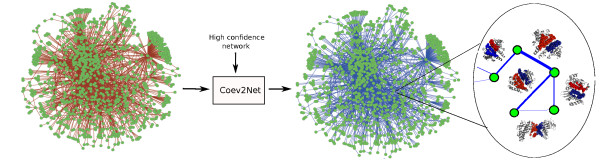
Framework for assessing confidence in a HTP PPI screen. Coev2Net, trained on a high-quality PPI network, is able to assign structure-based confidence scores for HTP PPI networks. Each node represents a protein and each edge the putative interaction between the two proteins. The thickness of an edge describes structure-based confidences of putative PPIs.